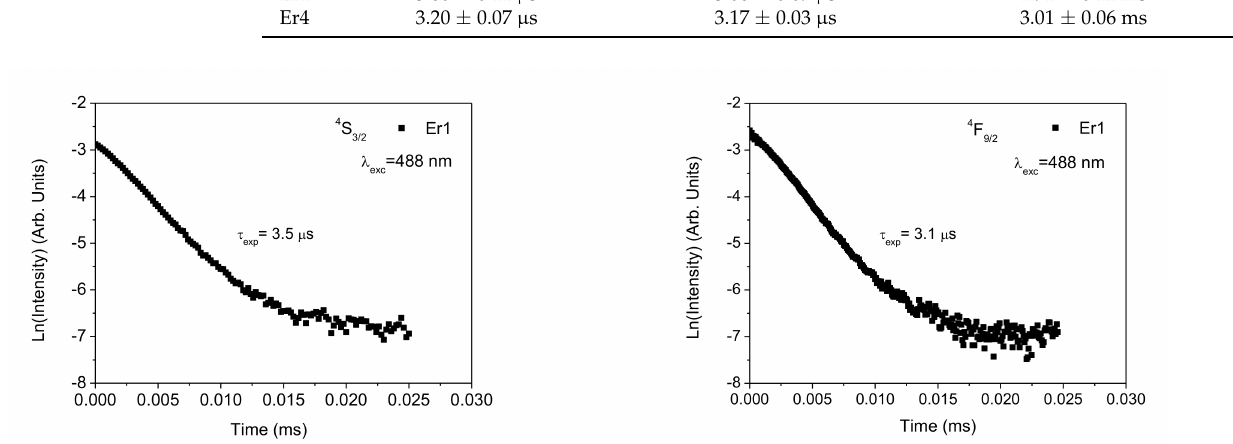
Figure 3. Experimental decays of the 4 S 3/2 and 4 F 9/2 levels of the Er-doped aluminosilicate glasses with 1 wt% under excitation at 488